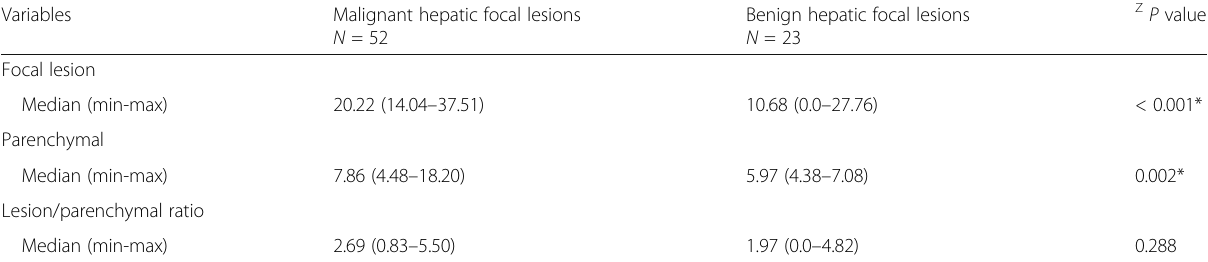
Table 4 Median stiffness value of benign and malignant lesions, the liver parenchyma and median lesion/parenchymal stiffness